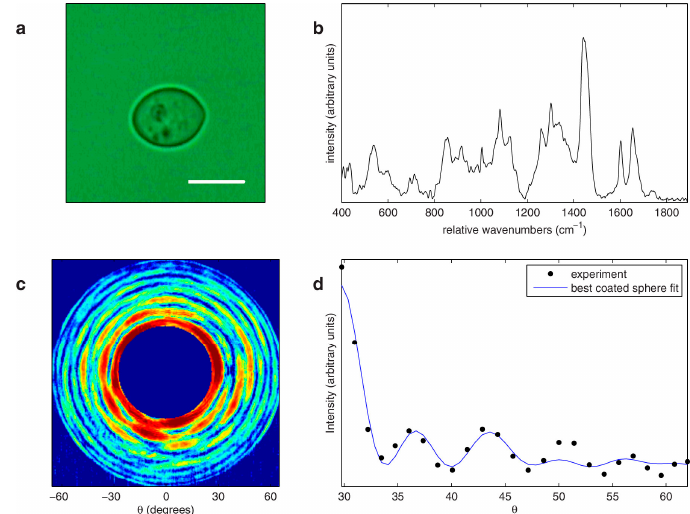
Figure 2. IRAM measurements of Saccharomyces cerevisiae. ( a ) Bright field image of the measured yeast cell. Scale bar indicates 5 μ m. ( b ) Raman spectrum from the yeast cell shown in ( a ). ( c ) Elastic scattering pattern from the yeast cell (color scale runs from blue (low) to red (high)). ( d ) Azimuthally averaged data from ( c ) (black dots) and associated best fit using a coated sphere model (solid blue line), with extracted core and coat diameters of 6.06 and 6.22 μ m, respectively. Reprinted from Smith et al., [94], with the permission from AIP Publishing.